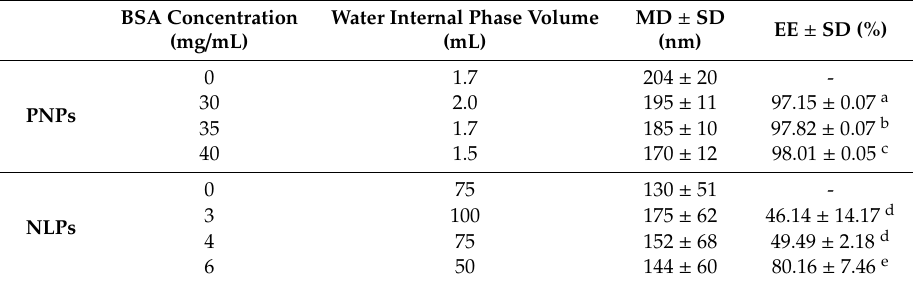
Table 1. Particle mean diameter and encapsulation efficiency of BSA-loaded nanocarrier prepared under different conditions. Results are expressed as mean ± standard deviation. Different letters (a, b, and c for PNPs) and (d and e for NLPs) reported in the EE column refer to statistically significant differences among the three different samples for each type of carrier ( p < 0.05) by ANOVA with Tukey’s HSD post hoc multiple comparison test. BSA: bovine serum albumin, MD: mean diameter, SD: standard